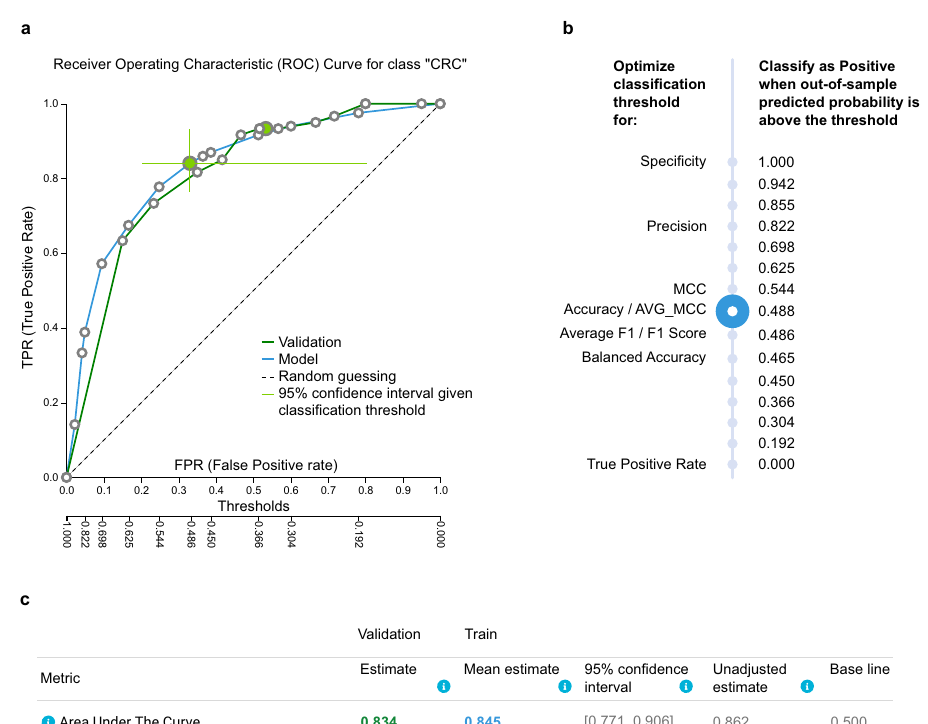
Fig. 2 Predictive performance of the winning model optimized for Feature selection, trained on the China (CN) cohort and validated on the Germany (DE) cohort. a The Receiver Operating Characteristic (ROC) curve estimated on the training set and controlled for trying multiple different con fi gurations is shown as the blue line. It shows all trade-offs between False Positive Rate (top x -axis) and True Positive Rate ( y -axis) for all different classi fi cation thresholds (bottom x -axis). By clicking on a circle, a corresponding threshold is selected. The user can see how metrics of performance are affected, which facilitates selection of the clinically optimal threshold. The green cross shows the con fi dence intervals in each dimension for that point on the ROC. The ROC curve achieved by the model ’ s predictions on the DE cohort used as external validation set is shown as the green line. It closely follows the blue line estimated from the training. b A list of different thresholds suggested by JADBio and the corresponding metric of performance that they optimize. E.g., accuracy is optimized for threshold 0.488, while balanced accuracy is optimized for 0.465. c The threshold-independent metric ROC Area Under the Curve (AUC) as estimated by the training (bold blue) and achieved on the validation (bold green) is reported along with its con fi dence intervals. Its unadjusted estimate (i.e., not adjusted for trying multiple con fi gurations) is also reported and is expected to be optimistic on average. All other estimates computed by JADBio, including but not limited to accuracy, precision, recall (not shown in the fi gure) are adjusted for trying multiple con fi gurations as